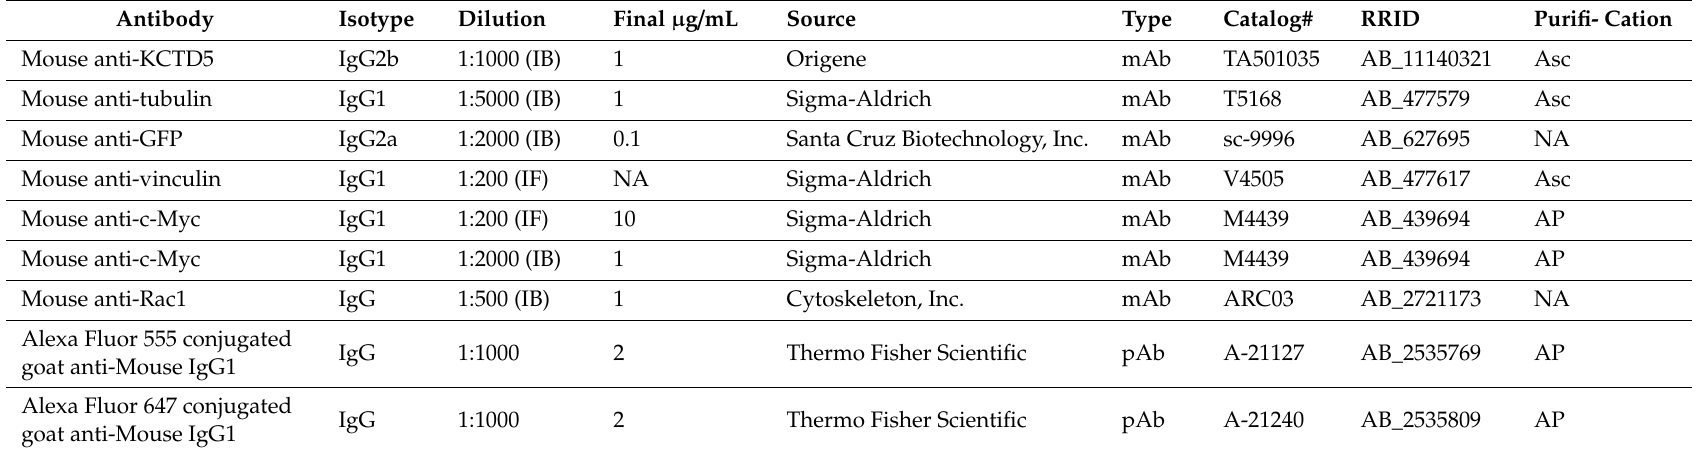
Table 1. List of